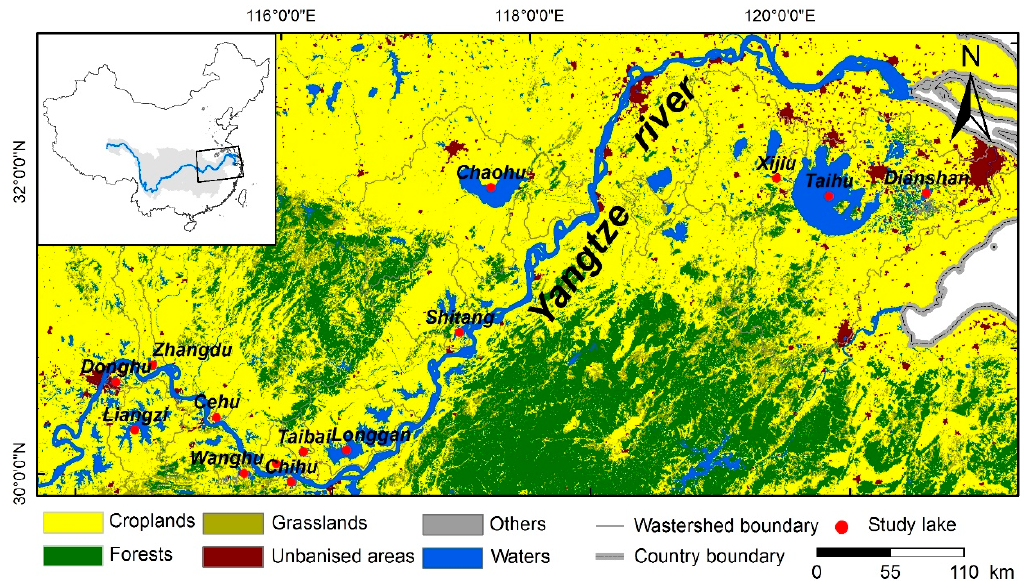
Figure 1. GIS maps showing the geographical distribution and land use for the 14 studied lakes from the Yangtze River basin (MLYB).